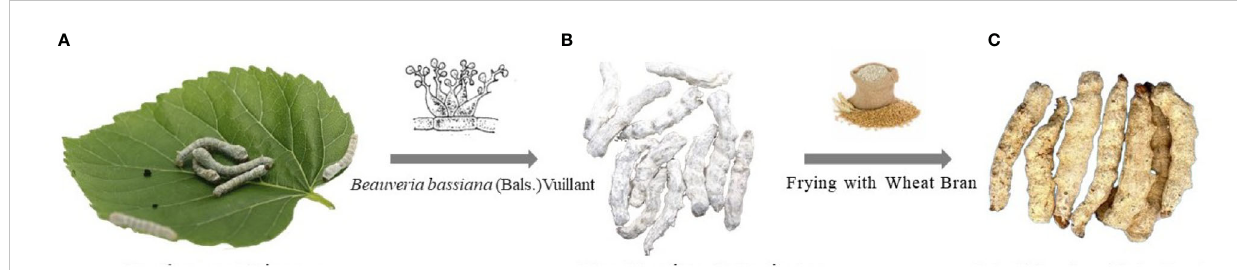
FIGURE 1 The formation of raw and fried Bombyx batryticatus. (A) Bombyx mori Linnaeus and mulberry leaves. (B) Raw Bombyx batryticatus. (C) Fried Bombyx